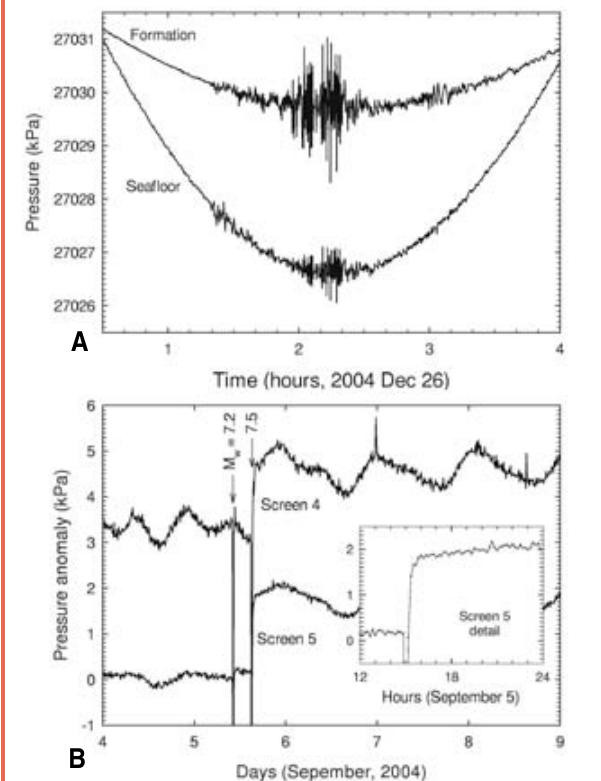
Figure 5. Indications of high recording fidelity from geologic signals. [A] Seismic waves from the December 2004 Sumatra Mw=9.0 earthquake. [B] Pressure steps observed in the sediments of the Philippine Sea plate off the Nankai subduction zone caused by regional volumetric strain associated with seismogenic rupture of the oceanic plate 220 km to the northwest off the Kii peninsula, Japan (Davis et al., 2007).